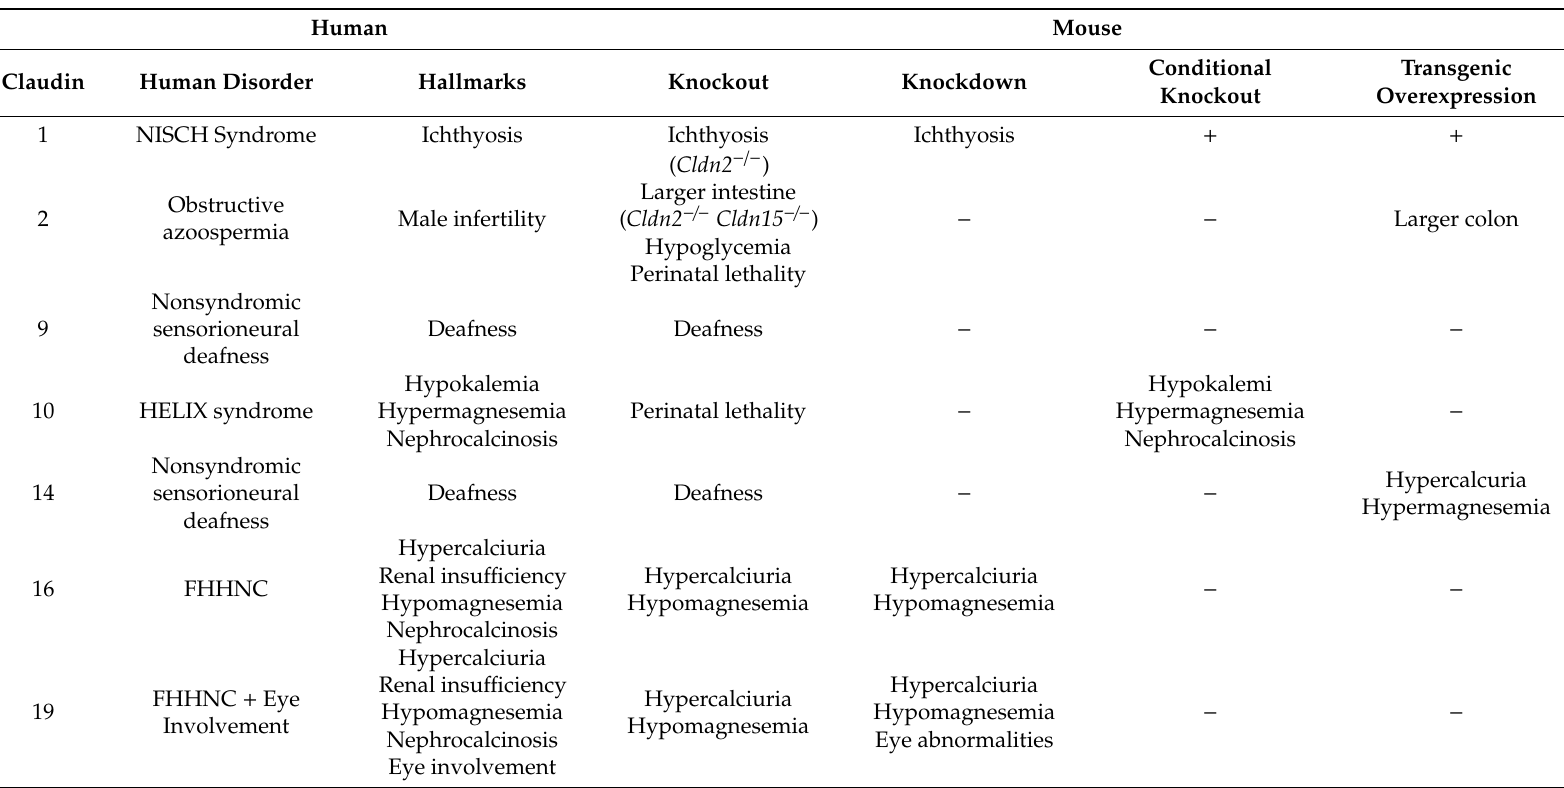
Table 1. Overview of claudins causing human diseases and corresponding mouse models. The existence (by publication) is indicated by ( + ) while ( − ) indicates the absence of a corresponding